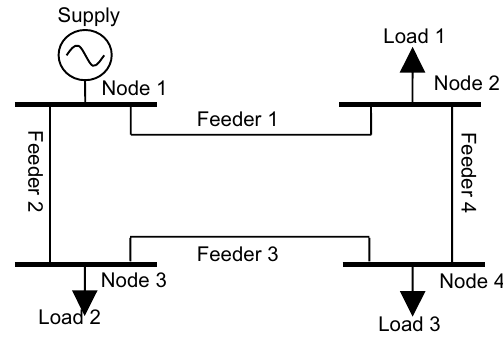
Fig. 1 A 4-node mesh